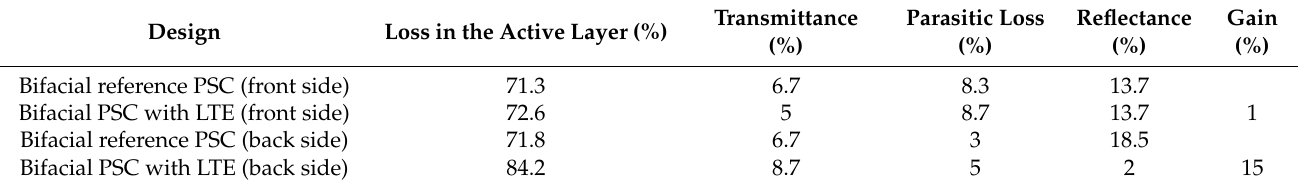
Figure 4. Optical efficiency analysis of bifacial PSCs calculated for λ = 350–800 nm. ( a ) Scheme of light trapping structure for the bifacial perovskite solar cell, D h is the diameter of holes ( D h = 900 nm), and D s —diameter of spheres ( D s = 940 nm), ( b ) spectral absorption, transmis- sion, and reflection for the front side illumination of the light trapping structure for the bifacial PSC, ( c ) spectral absorption, transmission, and reflection for the illumination of the back side of light-trapping structure for the bifacial PSC, ( d ) scheme of the reference bifacial PSC, ( e ) spectral absorption, transmission, and reflection for the front side illumination of the reference bifacial PSC, ( f ) spectral absorption, transmission, and reflection for the back side illumination of the reference bifacial PSC. Table 2. Optical characteristics of bifacial perovskite solar